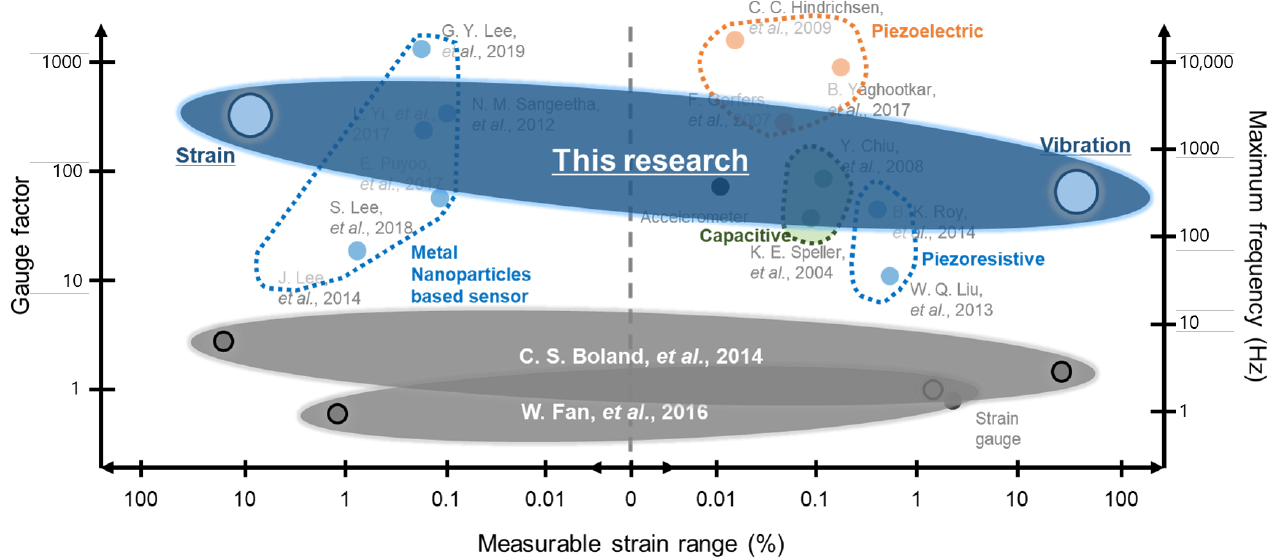
Figure 5. Comparison to previous studies according to sensitivity and maximum frequency.